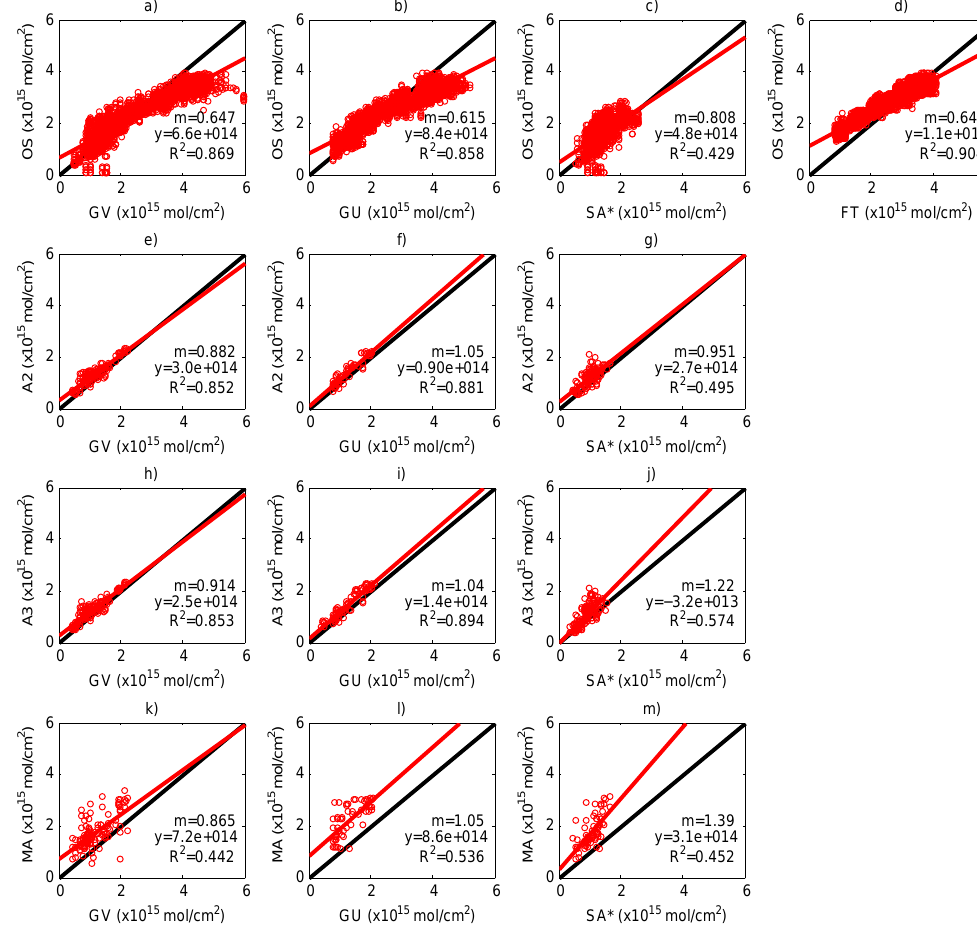
Fig. 13. As for Fig. 6, satellite versus ground-based NO 2 partial columns. Note that comparisons are not shown for ACE versus the Bruker FTIR because most ACE measurements above PEARL were for early spring and late fall when SZA > 80 ◦ and Bruker measurements were excluded for these SZA.